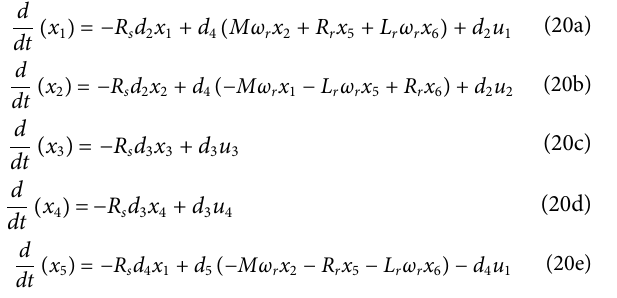
Frontiers in Energy Research |